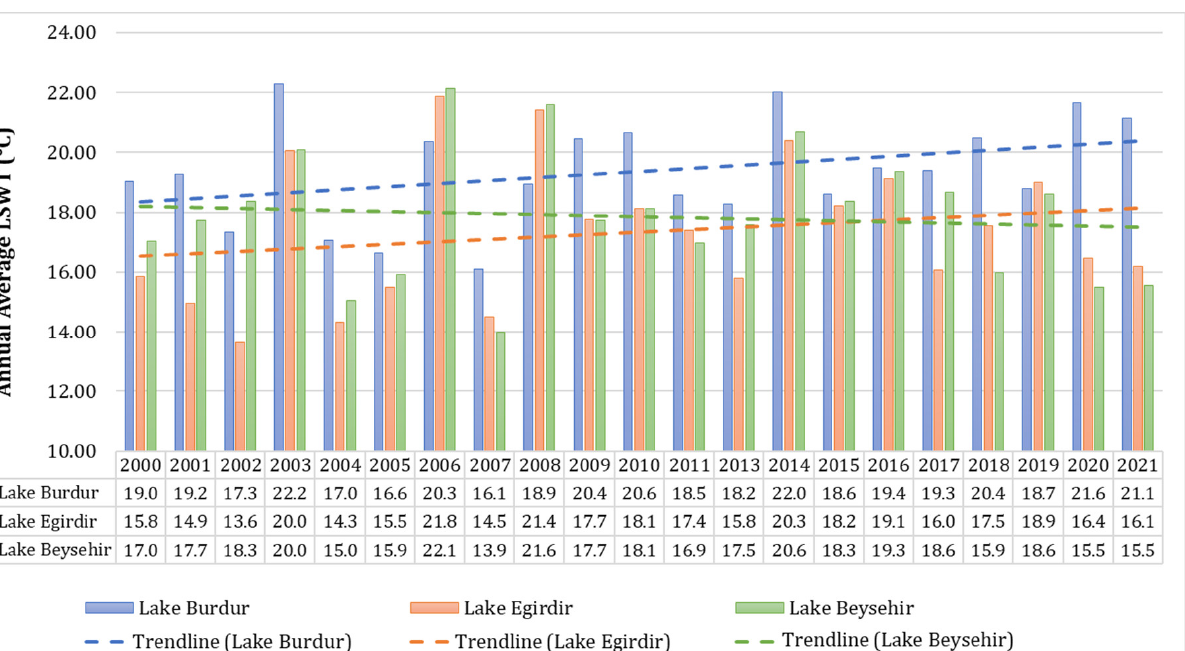
Figure 10. Beysehir Lake’s: ( a ) seasonal water surface area changes with RS images for 2000 and 2021; ( b ) long-term annual water surface area